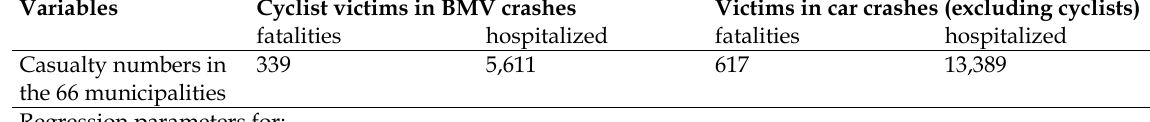
Table 4. Estimation results for regression on police-reported crash casualties (95% Wald CI)